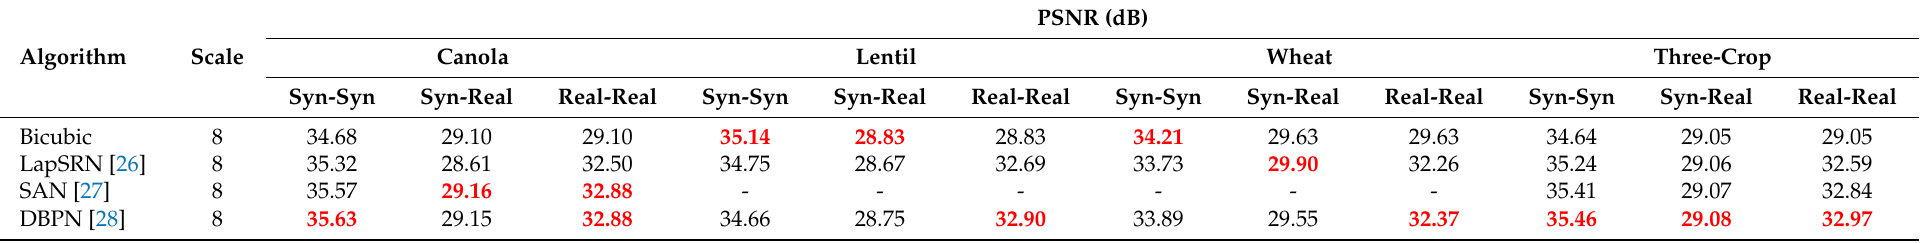
super resolution with different algorithms for the synthetic-synthetic, synthetic-real, and real-real experiments. The highest values are indicated in red . Table 3. Average PSNR for 8 ×